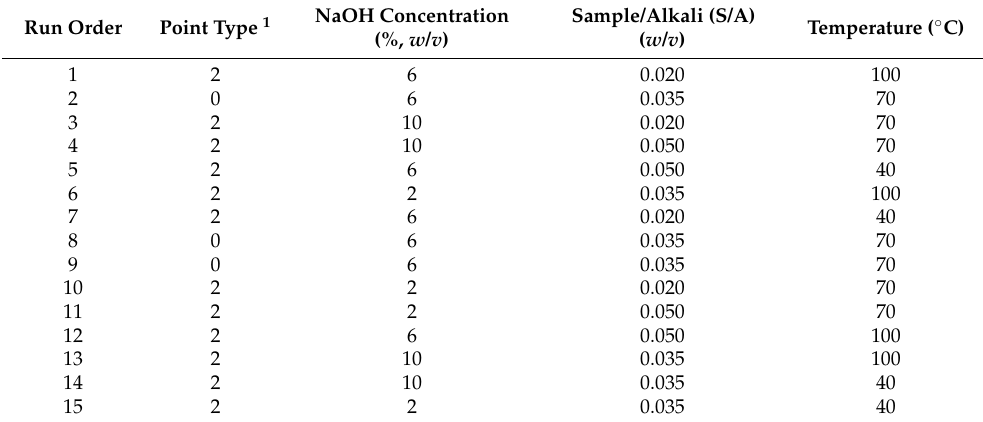
Figure 1. Alkali treatment steps from dried parsley stalks. ( a ) Dried parsley stalks; ( b ) PF (untreated parsley stalks fiber); ( c ) PSE (alkali-treated parsley stalks fiber extracted in run order 7). Table 1. Experimental design for alkali extraction